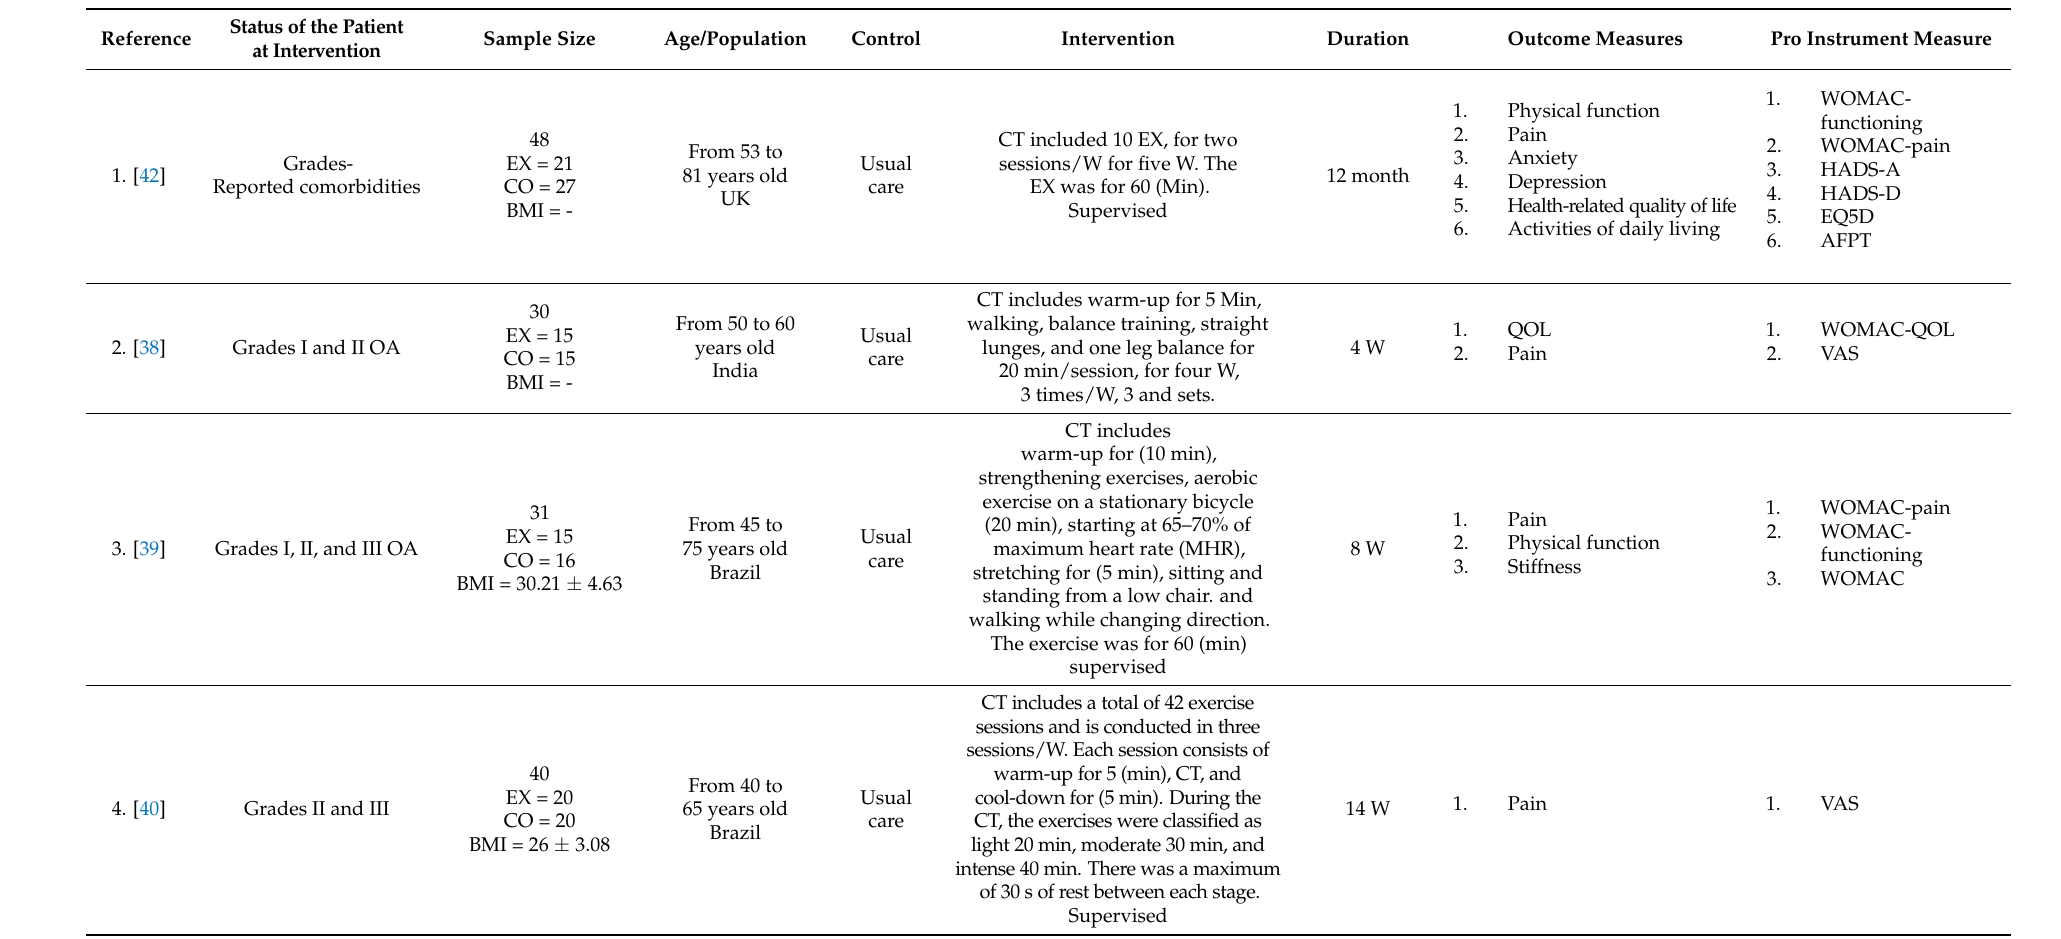
Table 1. Characteristics of the included